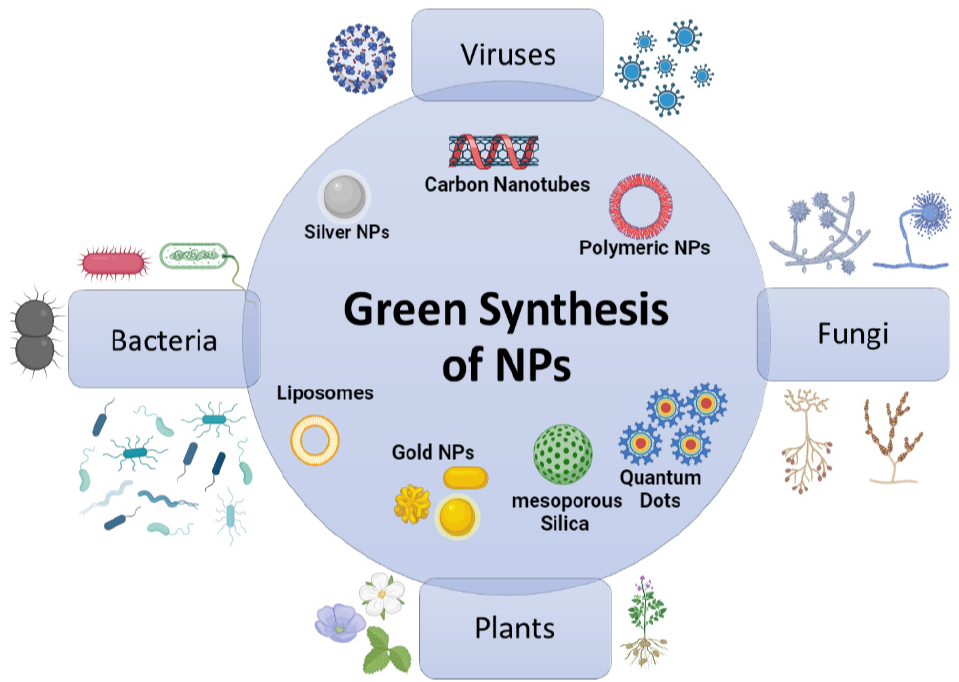
Figure 6. The various bioactive agents used in the green synthesis of nanoparticles.